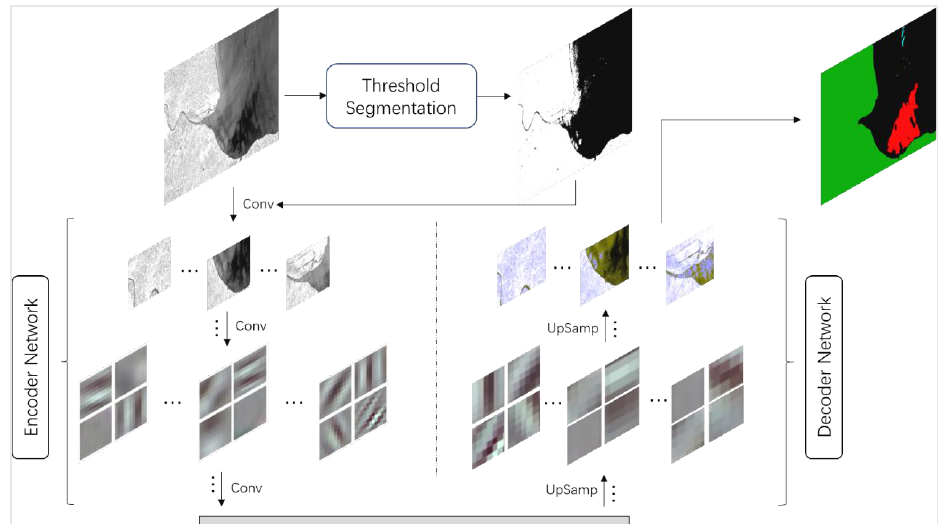
Figure 6. Schematic depiction of FMNet architecture used for segmentation. The traditional threshold segmentation algorithm is combined with the deep learning model to form FMnet. The global features provided by the threshold segmentation model reduce the noise for the feature extraction of the depth model, and also provide more clear boundary features in the segmentation process. The equipment used in this experiment included a GeForce RTX 2060 with a core frequency of 1770 MHz and a video memory capacity of 6 GB. The CPU is a 10400 version of Intel i5, with a frequency of 2.9 GHz. The memory size of the device was 16 GB. Table 1. Pseudo code of the FMNet segmentation algorithm.